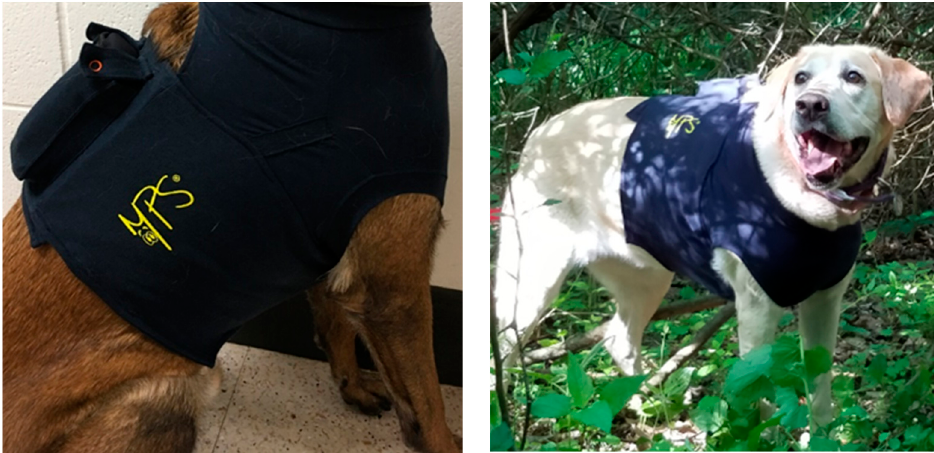
Figure 4. Medical vest worn by human remains detection canines during simulated tactical deployment